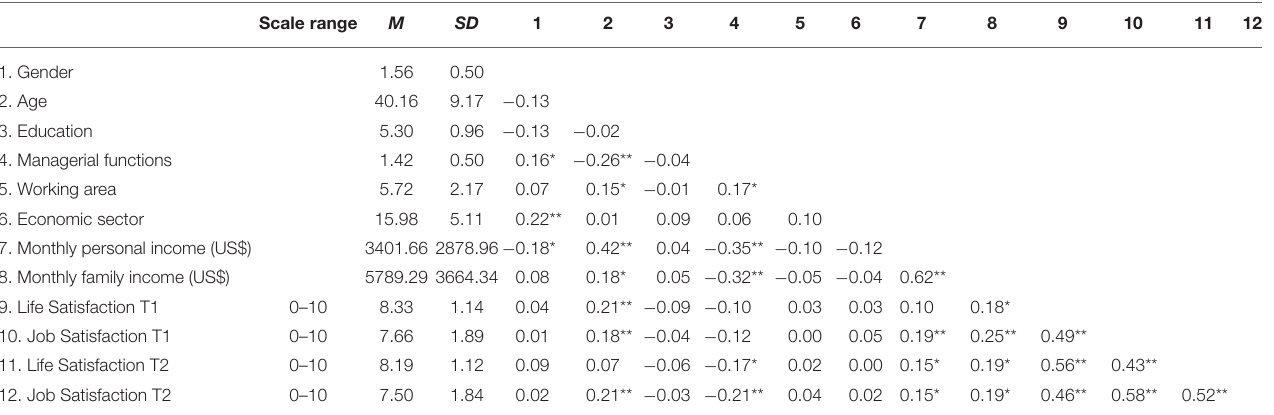
TABLE 2 | Descriptives and inter-correlations between all study 1 variables, at Time 1 (T1) and Time 2 (T2) (longitudinal